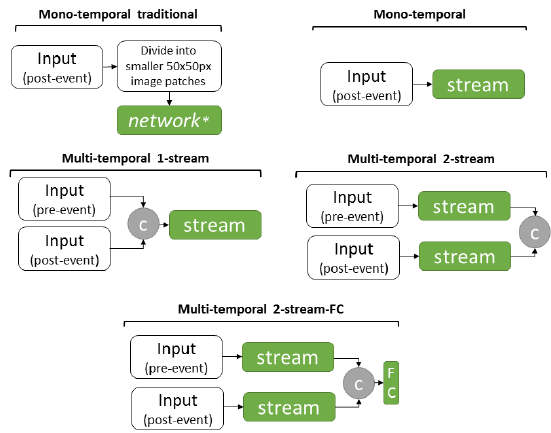
Figure 7. Mono- and multi-temporal approaches considered in this study. * refers to the network used in Duarte et al.